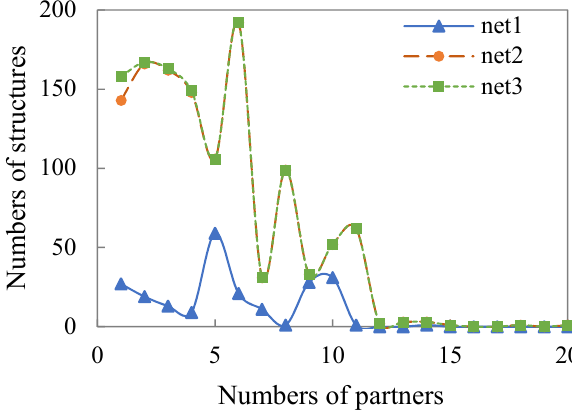
Figure 4. The number of DSP (dyadwise shared partners).